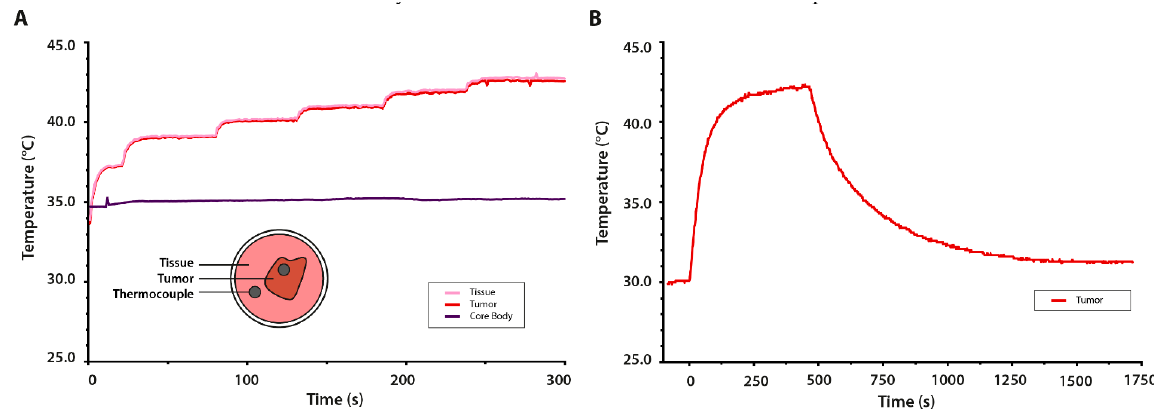
Figure 7. In vivo temperature measurements in the dorsal skinfold chamber. ( A ) Temperature distribution in the window at multiple locations during interval heating; the temperature was manually set 1 degree Celsius higher per interval after first reaching 37.0 °C. ( B ) The intratumoral temperature during mild hyperthermia application; the temperature increased from steady state temperature in the window to the set target temperature of 42.0 °C, after which the power was shut down to track the cool down.